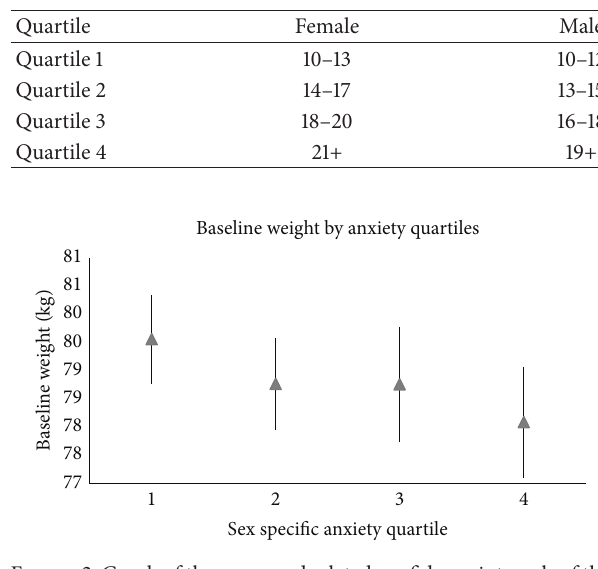
Figure 2: Graph of the mean and related confidence intervals of the baseline weight (kg) by sex-specific anxiety